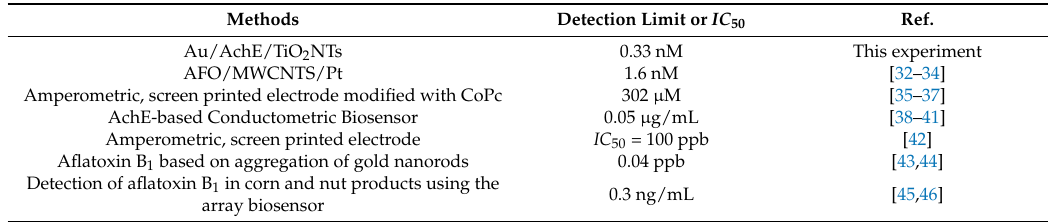
Table 1. Several Biosensors for aflatoxin B 1